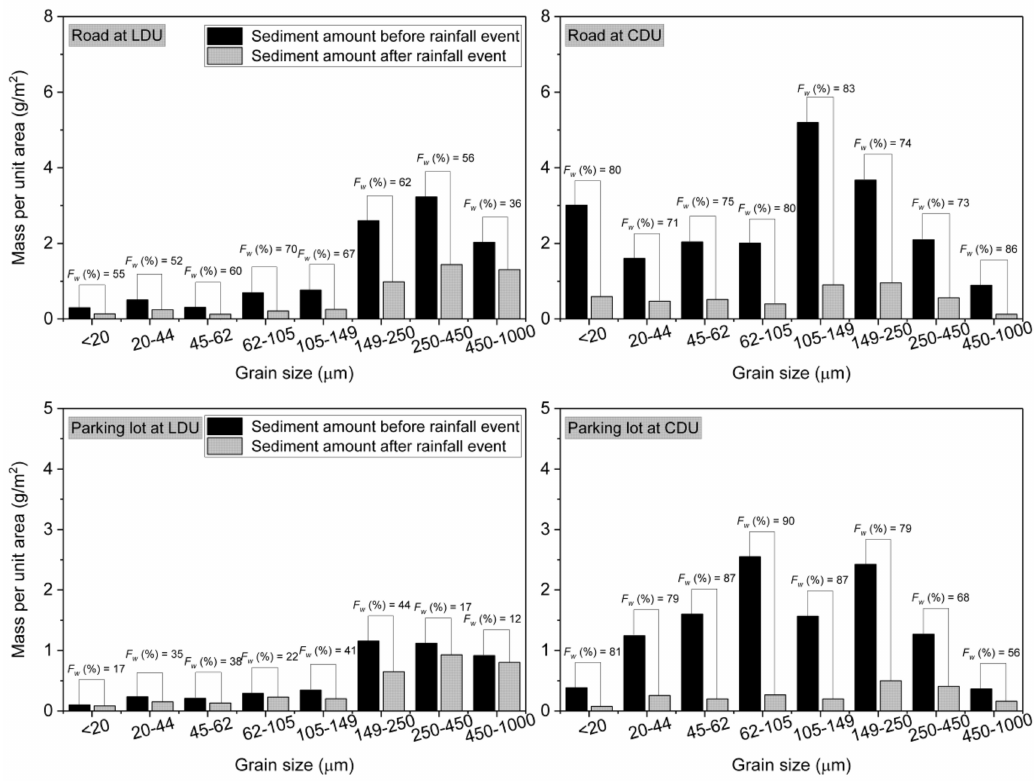
Figure 4. Variations in urban sediment amount before and after rainfall events. LDU = LID residential drainage unit; CDU = conventional residential drainage